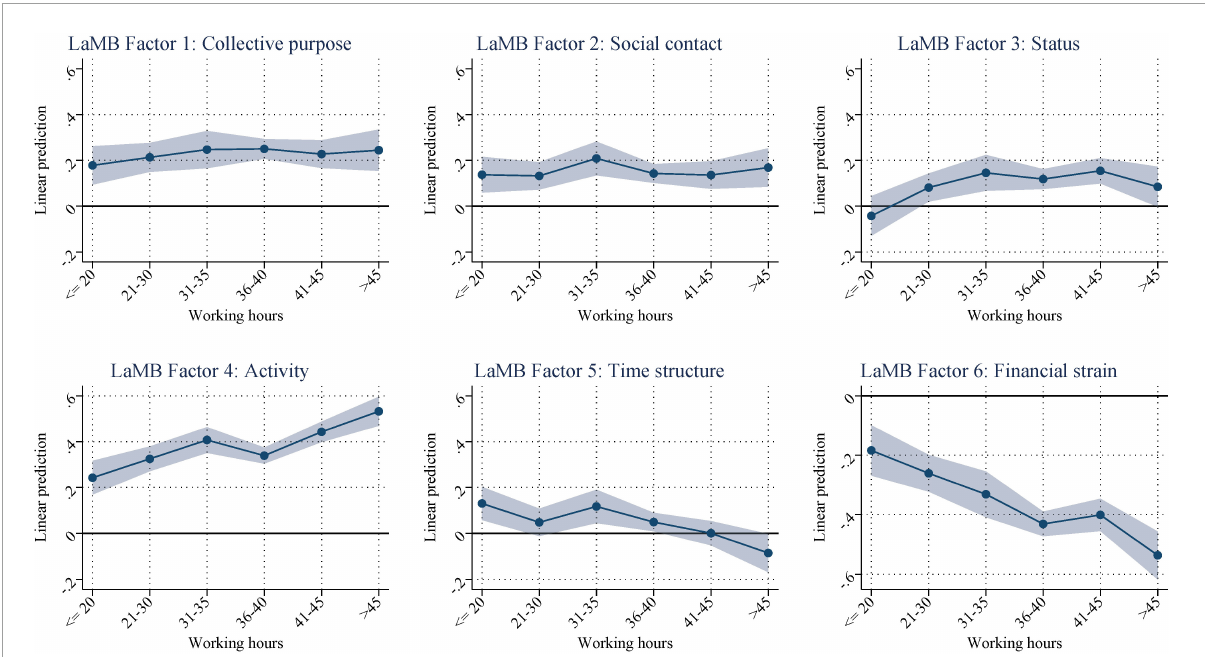
FIGURE2 Conditional on working: predicted scores by categories for hours worked (net of the effects of an hourly wage, welfare benefit receipt, age, age squared, gender, education, partner in HH, child (under 15) in HH, 4-digit-ISCO, and interview mode). Supplementary Appendix Table A7 shows the corresponding regression results.